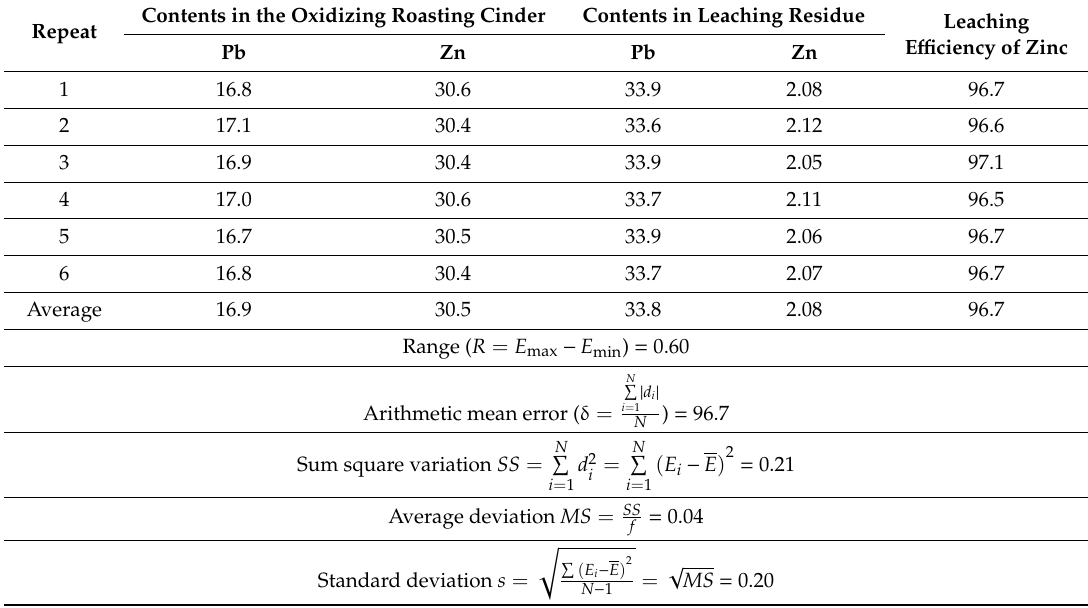
Table 5. Repeated scale-up test results (wt